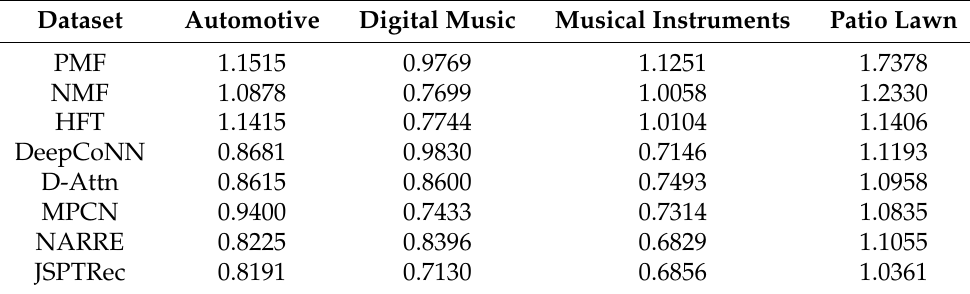
Table 3. Experimental results on four subdatasets from Amazon review data.